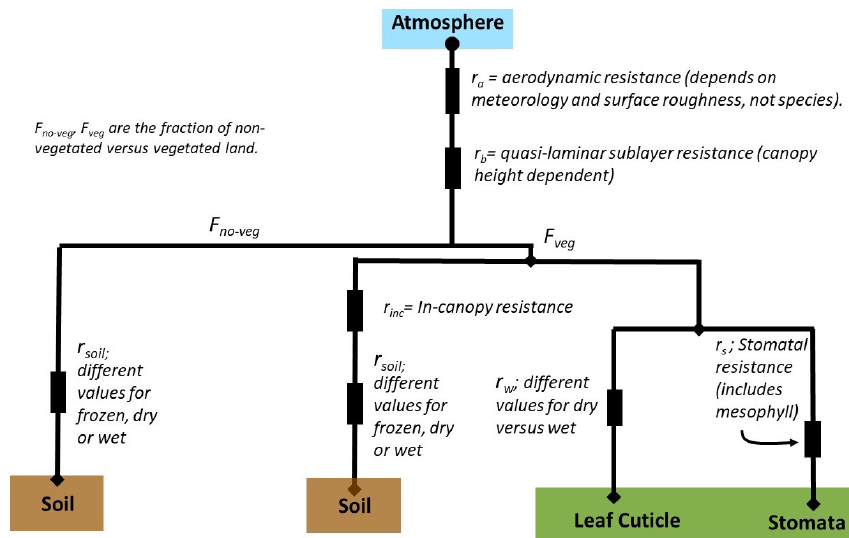
Figure B4. Resistance diagram for the dry deposition scheme implemented in LOTOS